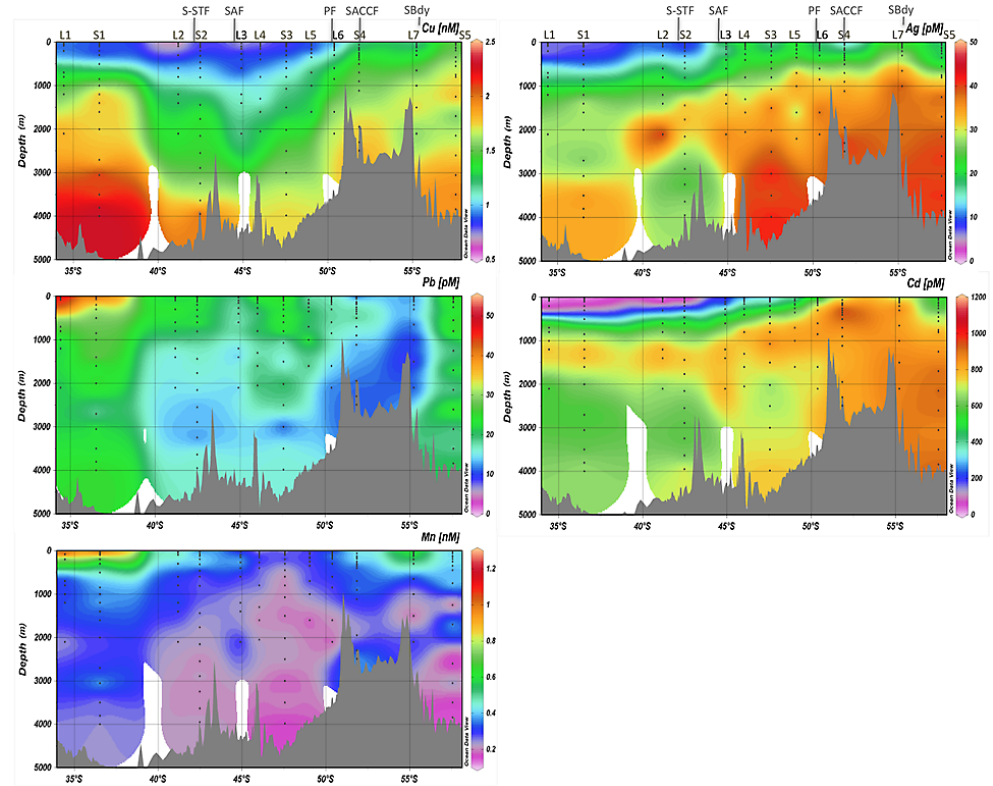
Fig. 3. Contour plots of dissolved copper (Cu, in nM), silver (Ag, in pM), lead (Pb, in pM), cadmium (Cd, in pM) and manganese (Mn, in nM) along the MD166 BONUS-GoodHope section between the southeastern Atlantic and the Southern Ocean. The positions of L and S stations and the fronts are indicated. The colour map gridding is based on the sampling resolution along the section of ∼ 2600km that was achieved with 12 stations separated on average by ∼ 2.2 ◦ latitude, with a total of 160 sampling depths. Figure prepared using Ocean Data View (Schlitzer,